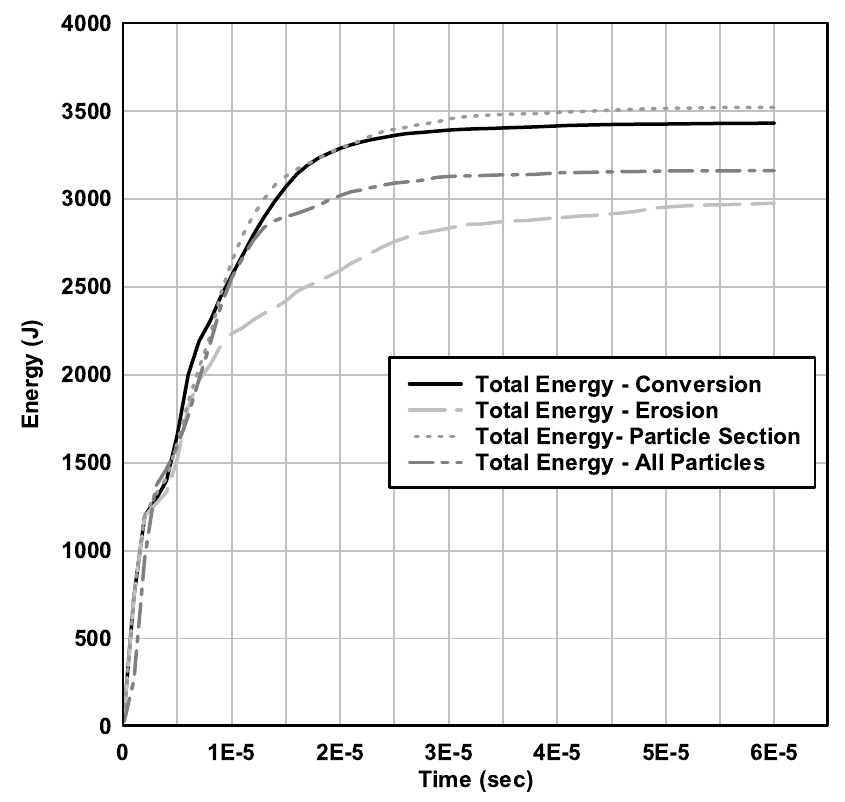
Fig. 12. Total energy of the 6.35 mm thick target